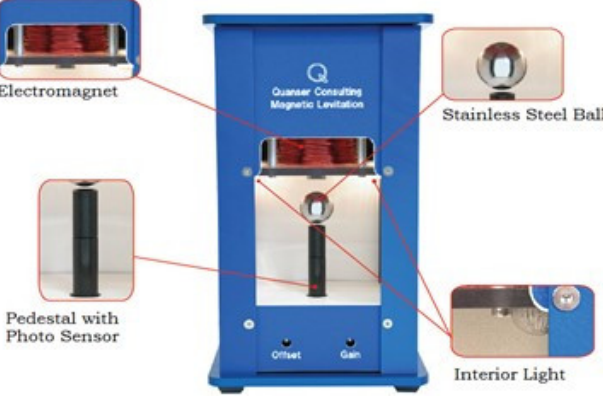
Figure 1. Magnetic levitation system.